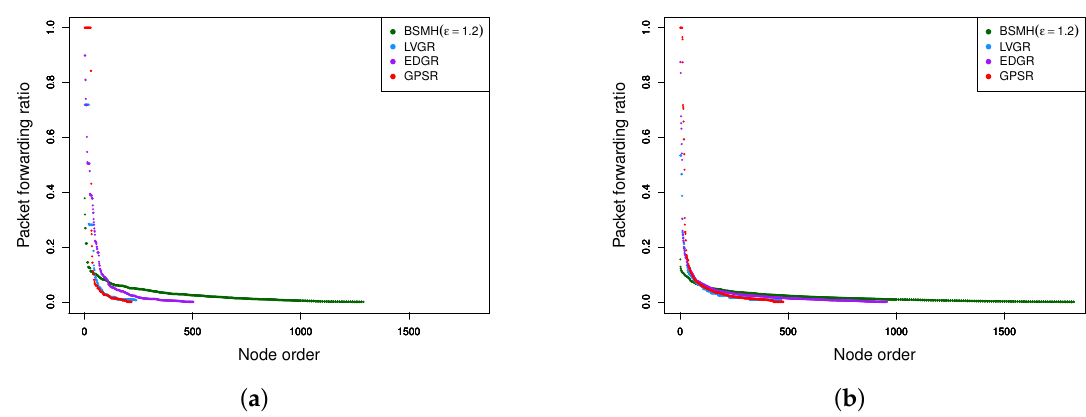
Figure 19. Packet forwarding ratio distribution regarding Topology 4. The x-axis represents the node orders that are sorted by the descending order of the packet forwarding ratio. The y-axis represents the packet forwarding ratios and the x-axis represent the orders of the nodes. ( a ) 1-n communication. ( b ) n-n communication.